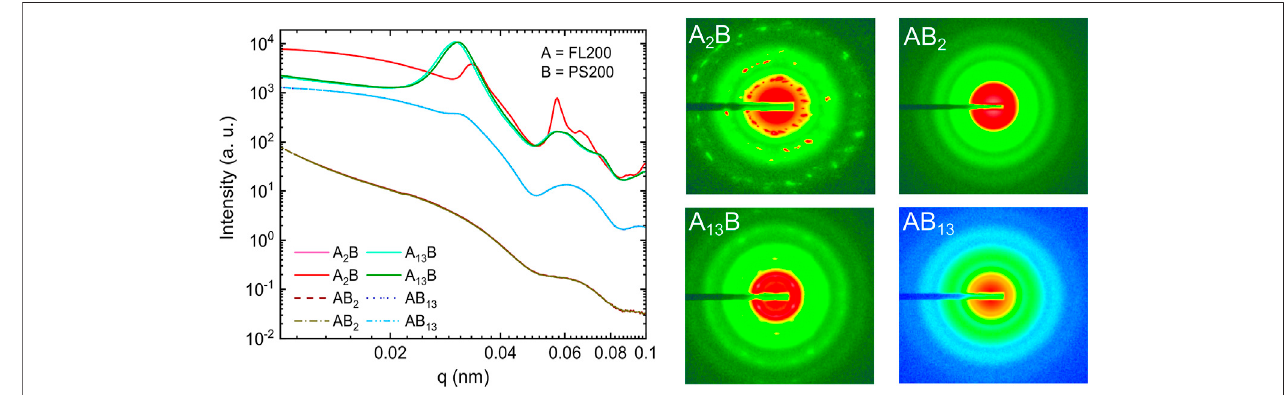
FIGURE7 | SAXS measurements ofmixed FL190 and PS200 in deionized water with atotal volume fraction ofabout 30%. All four samples were measured in two differentplaces,re fl ectedbythetwodifferentlinesforeachmixture.Theyarealmostidenticalandfallontopofeachother.Theintensitieswerecorrectedforbackground but the Form Factor was not divided